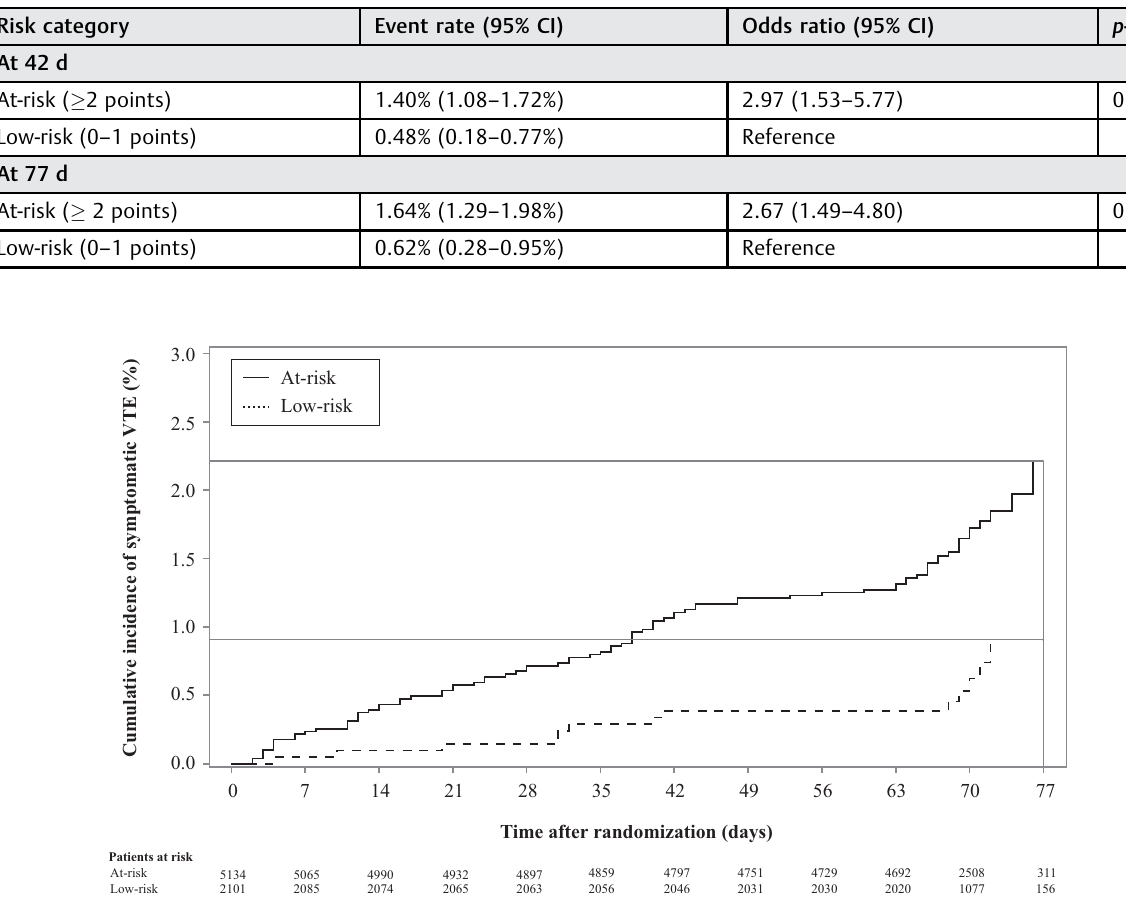
TH Open Vol. 1 No.